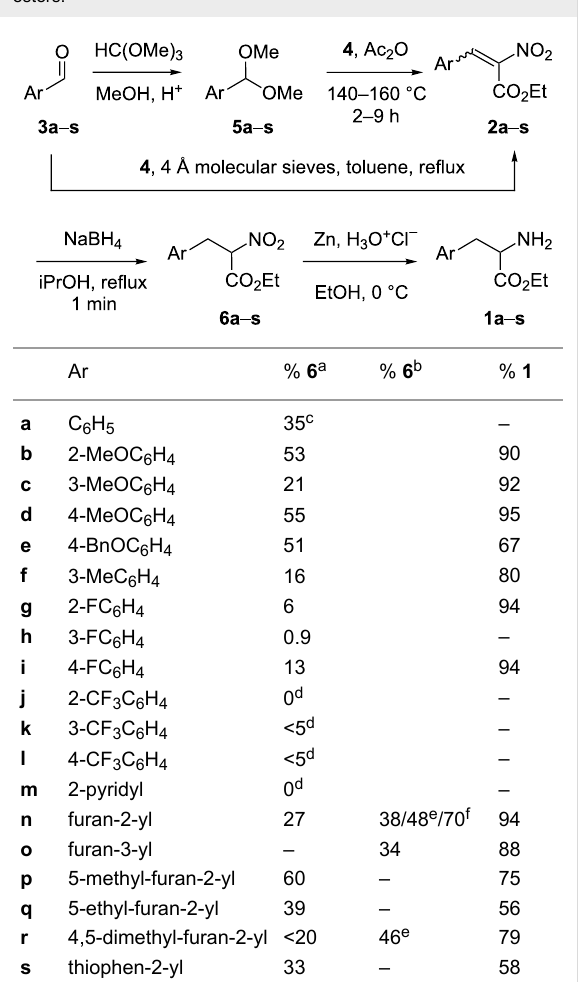
Table 1: Synthesis and reductions of α -nitro acrylates into α -amino